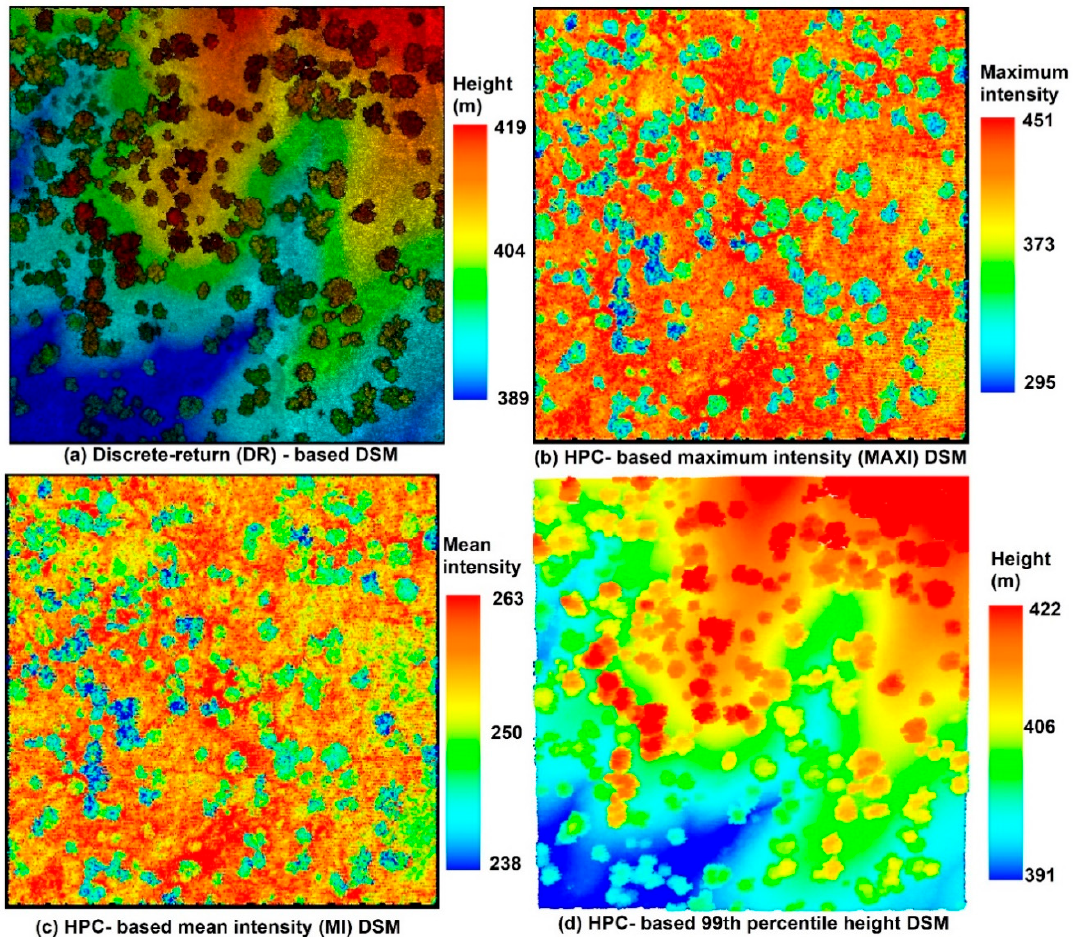
Figure 5. Preliminary results of ( a ) the discrete-return (DR)-based digital surface model (DSM) and ( b ) the HPC-based MAXI DSM, ( c ) HPC-based MI DSM, and ( d ) HPC-based 99th percentile height (PH) DSM from the hyper point cloud (HPC).